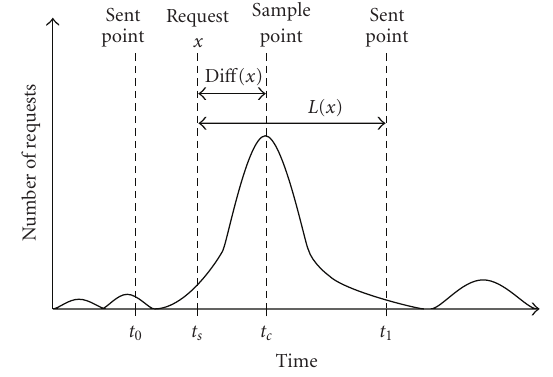
Figure 5: On-demand delivery scheme. Here, t 0 is the sent time of the last snapshot, t s is the snapshot ordered by a user request x , t c is the snapshot of most users, t 1 is the sent time of the current